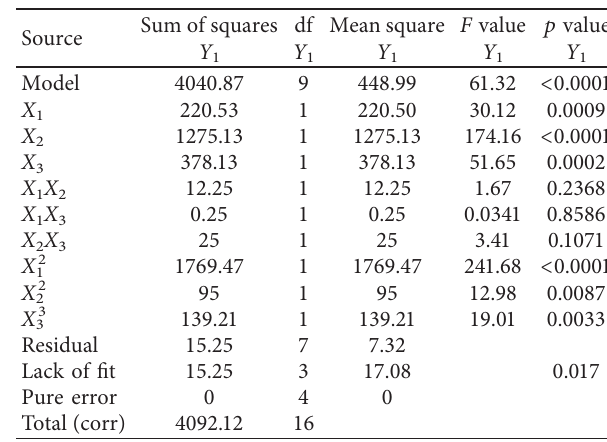
Table 3: ANOVA test for response parameters.